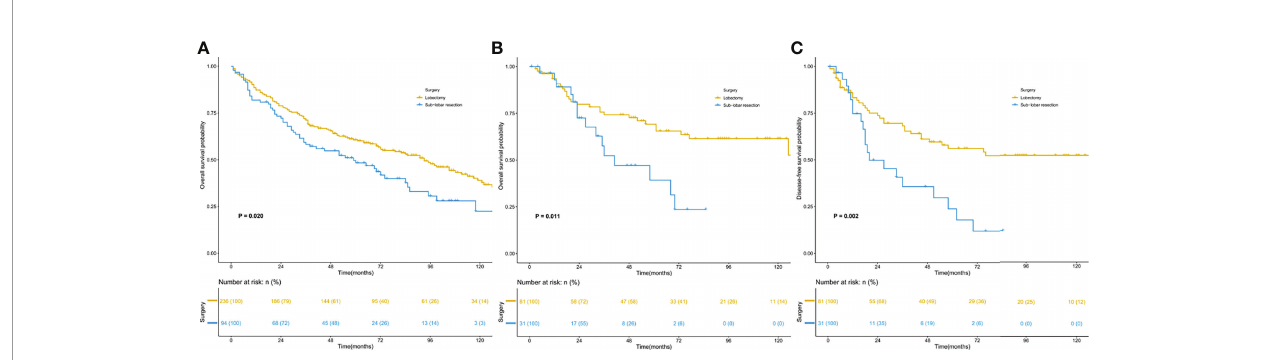
FIGURE 3 | Kaplan – Meier survival curves for patients with stage I. (A) overall survival of the SEER cohort; (B) overall survival of the SPH cohort; (C) disease-free survival of the SPH cohort. SEER, Surveillance, Epidemiology, and End Results; SPH, Shanghai Pulmonary Hospital.